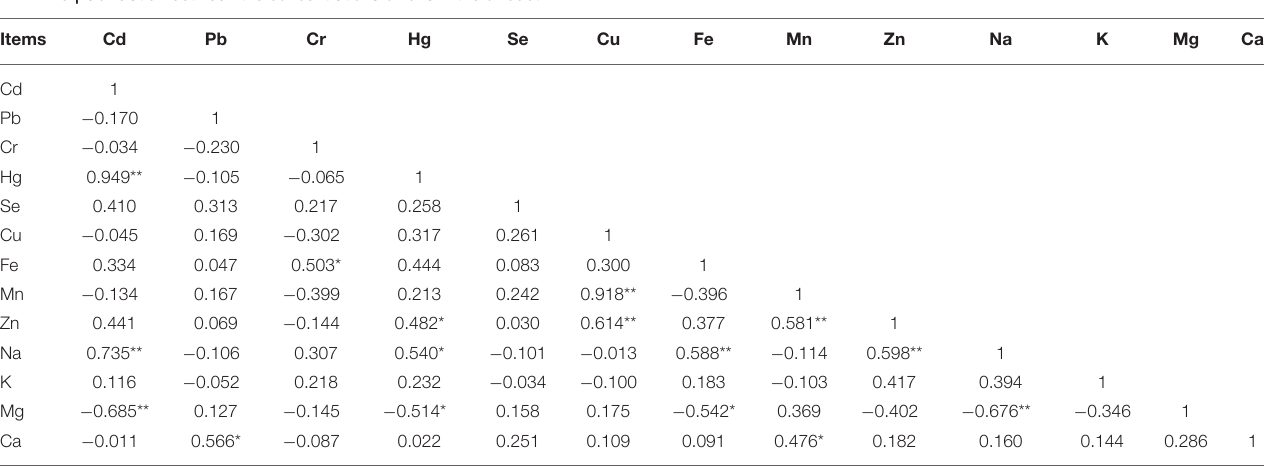
TABLE 5 | Correlation between the concentrations of ions in the